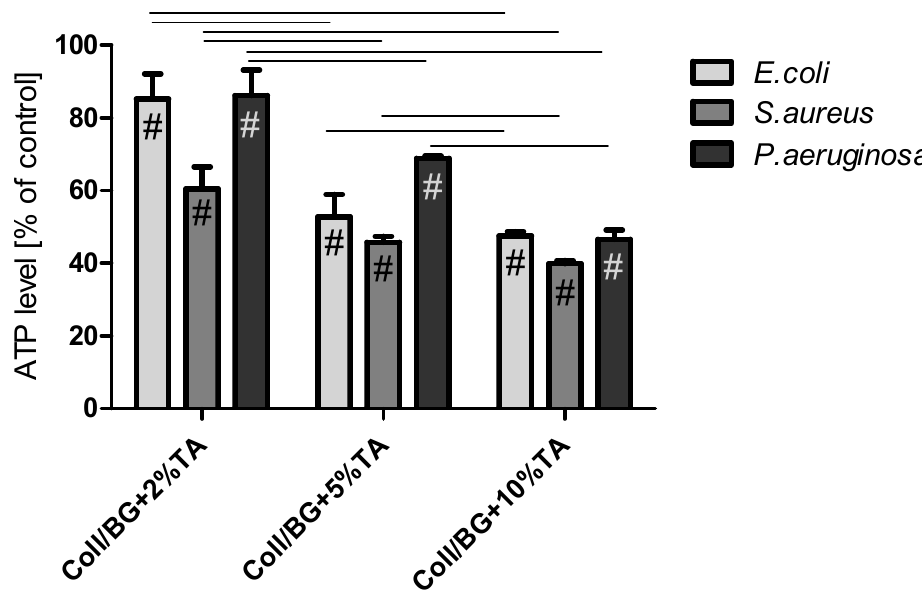
Figure 6. Released ATP levels of Escherichia coli, Staphylococcus aureus, and Pseudomonas aeruginosa after 1 h contact with hydrogels (#—significant difference with the control; lines between bars mark significant differences between groups).